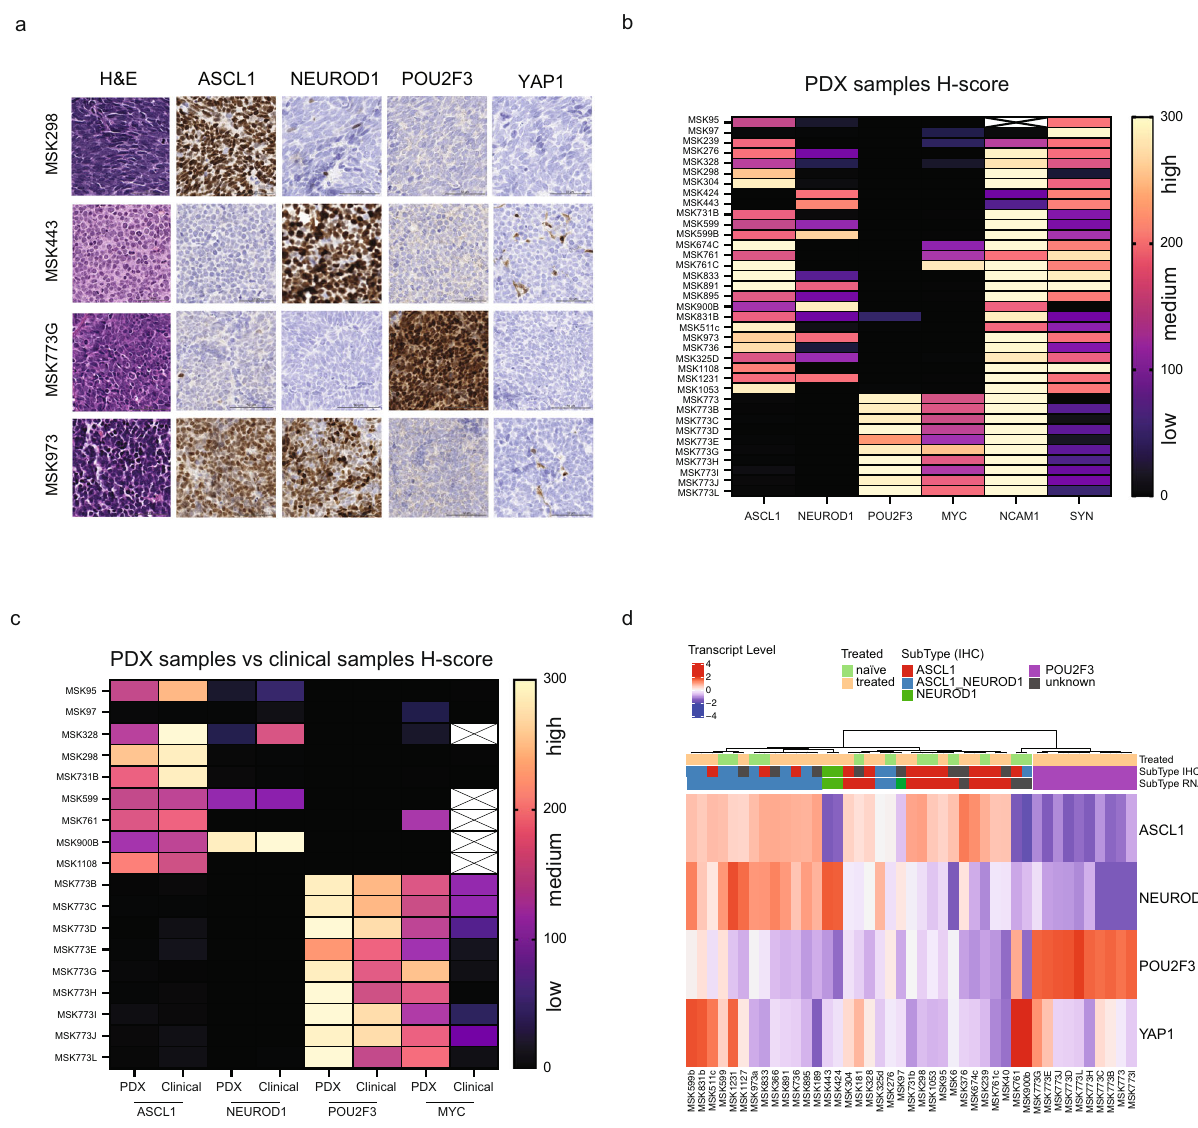
Fig. 3 SCLC subtype annotation and neuroendocrine markers. a H&E and immunohistochemistry images for the indicated proteins are shown. Scale bar, 50 μ M. Four representative tumors are shown. Three independent cores per sample were stained for H&E and the indicated protein with a representative example shown here. b Heatmap depicts H-scores derived from 37 scored patient-derived xenograft (PDX) tumors for the fraction of positive cells for each protein shown, as well as staining intensity. White box with a cross (MSK95, NCAM1) indicates staining failed. Source data are provided as a Source Data fi le. c Heatmap depicts H-scores derived from 18 paired PDX tumors and clinical samples for the fraction of positive cells for each protein shown, as well as staining intensity. White boxes with cross indicate no staining available. Source data are provided as a Source Data fi le. d Heatmap of gene expression of 43 PDX samples for the selected markers; ASCL1, NEUROD1, POU2F3, and YAP1. Color-coded panel on top depicts treatment status (naïve or treated)